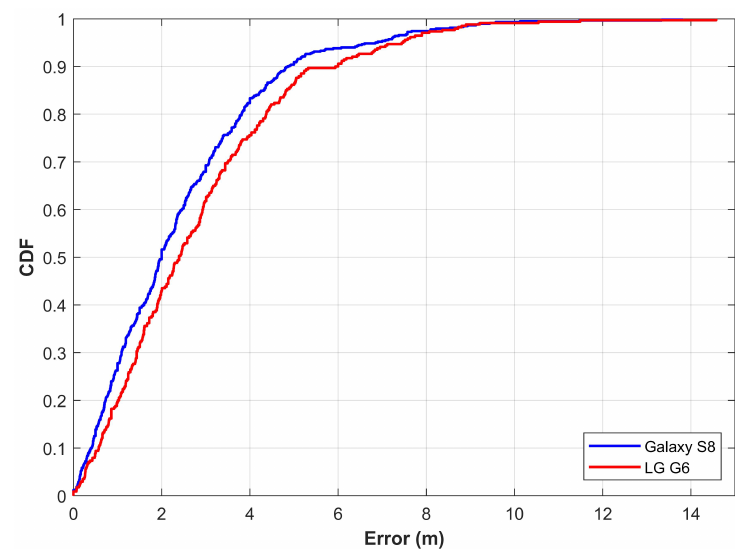
Figure 12. The CDF graph when localizing with features extracted from continuous walk data.